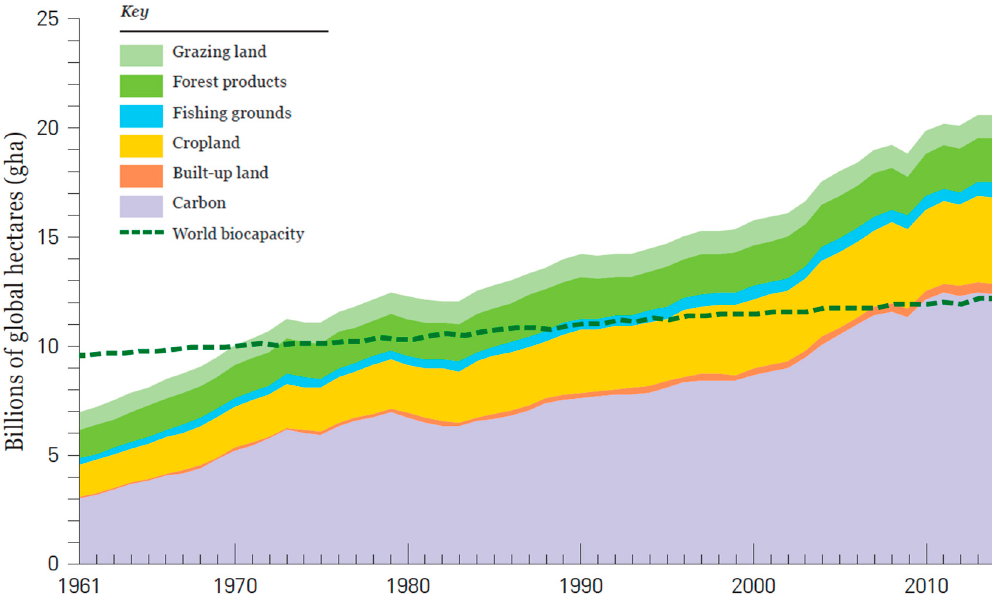
Figure 2. Global Ecological Footprint, 1961–2014. Source: WWF—World Wide Fund for Nature (2018) Living Planet Report—2018: Aiming Higher, © 2018 WWF—All rights reserved.